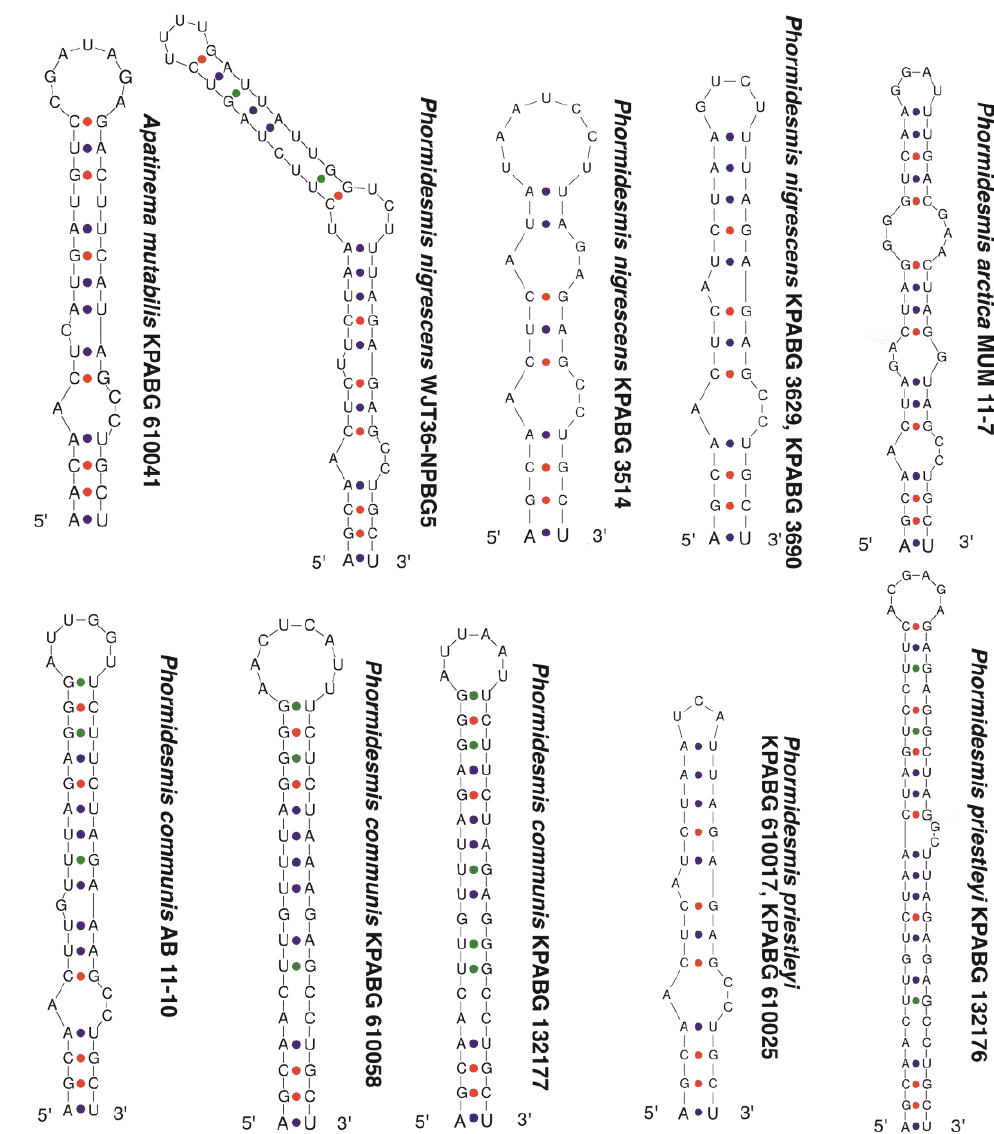
τη ) (Greek, fem. n.)—to deceive, confuse, and refers to the appearance of the organism in Apatity town; nema (N.L. neut. n.) thread,